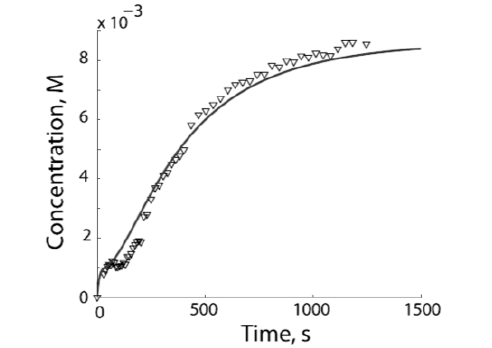
Figure 3. Kinetics of polarized NMR line of alkene a(-H) during thermolysis of 0.02 M solution of 3a (b) in m -C D Cl at 386 K in the presence of 6 eq of thiophenol : 6 4 2 symbols—experimental data points, solid lines—calculated dependence vs.